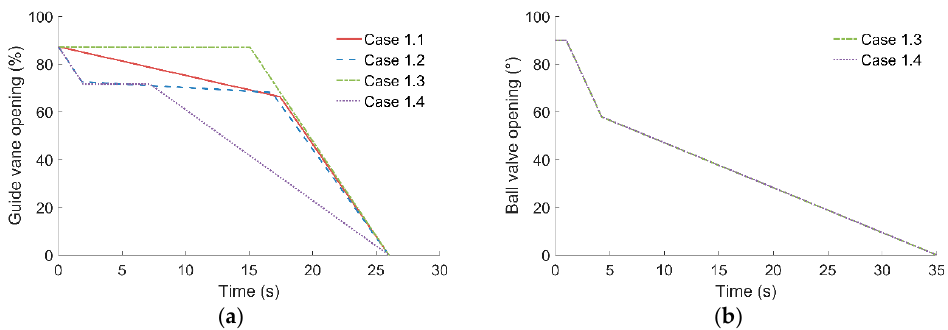
Figure 12. Optimized closing schemes in Case 1 for ( a ) guide vanes and ( b ) ball valve.